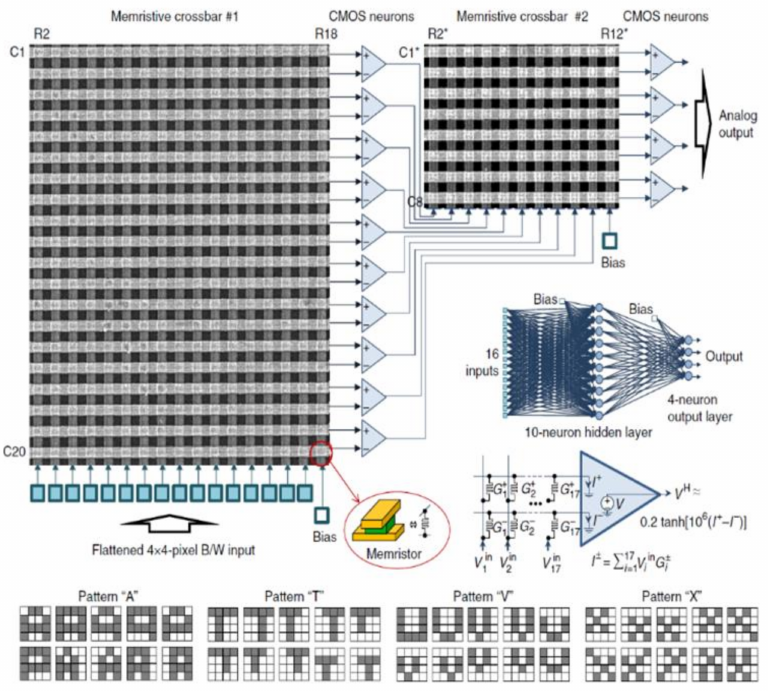
Figure 16. Three-layer fully connected perceptron network realized though Pt/Al 2 O 3 /TiO 2 − x /Ti/Pt memristor